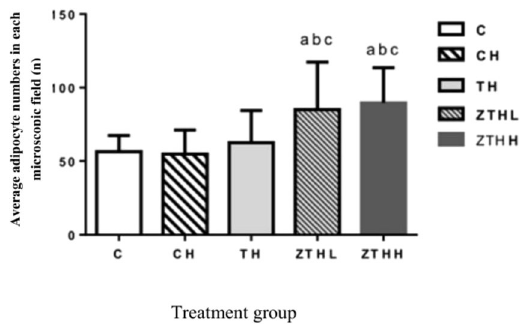
Figure 11. Comparison in the number of adipocyte in different treatment groups in histological examination. a Vs C-group, p < 0.05; b vs CH-group, p < 0.05; c vs TH-group, p <